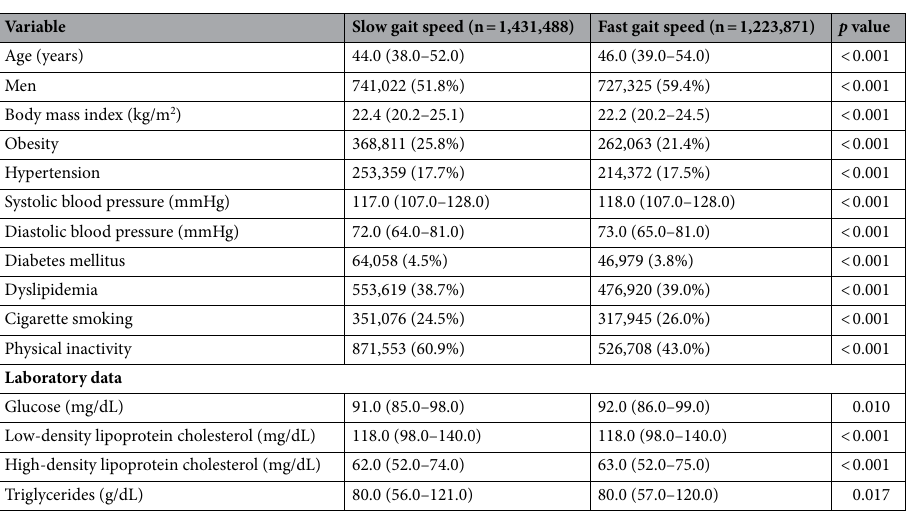
Table 1. Clinical Characteristics. Data are expressed as median (interquartile range) or number (percentage). We obtained information on gait speed from questionnaires during health check-ups. If a study participant answered “YES” to the following question: “Do you walk faster than others of the same age and sex?” then this study participant was categorized as having fast gait speed. If a study participant answered “NO” to this question, then this study participant was categorized as having slow gait speed.